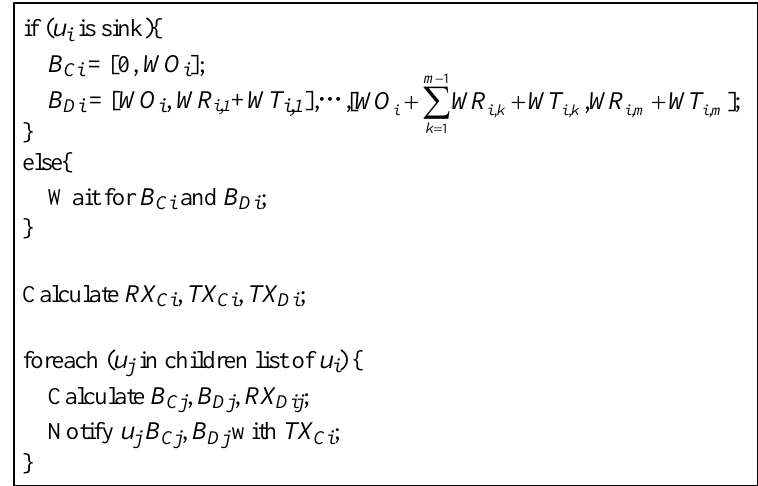
Figure 5. Time pool allocation and time slice